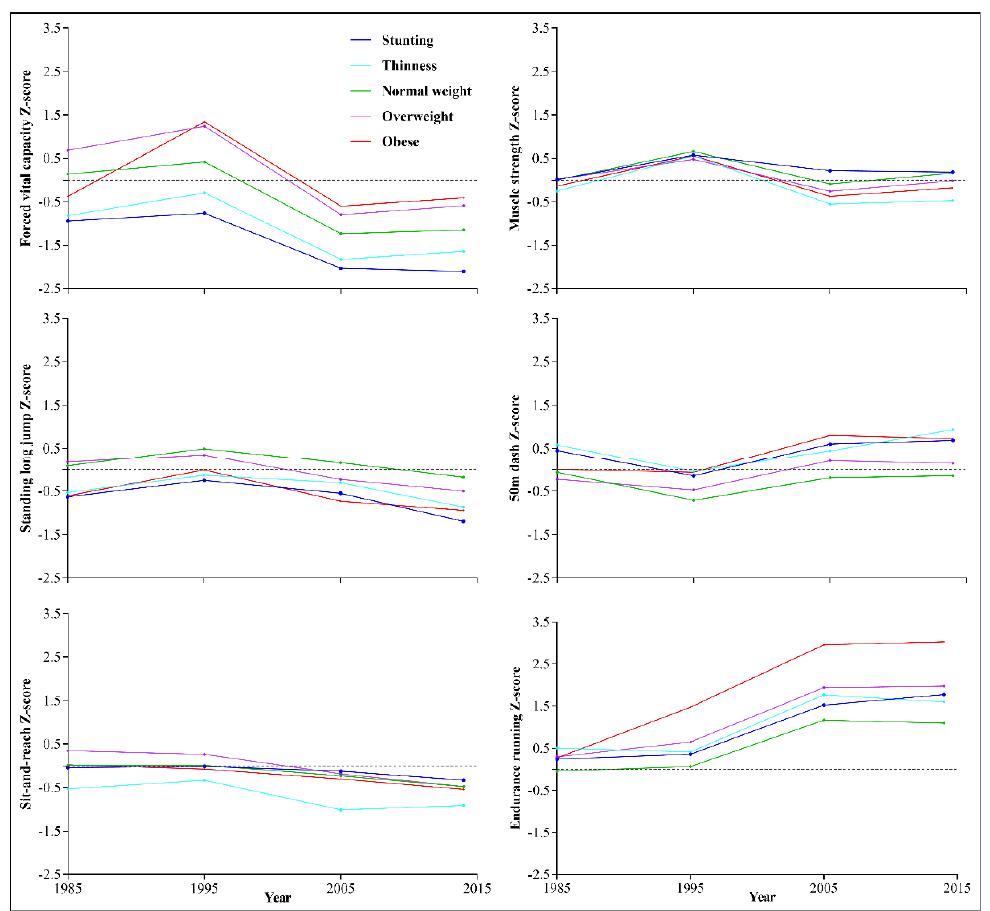
Figure 4. Trends in the six core items of physical fitness among boys in Xinjiang with different nutritional status, 1985 to 2014.